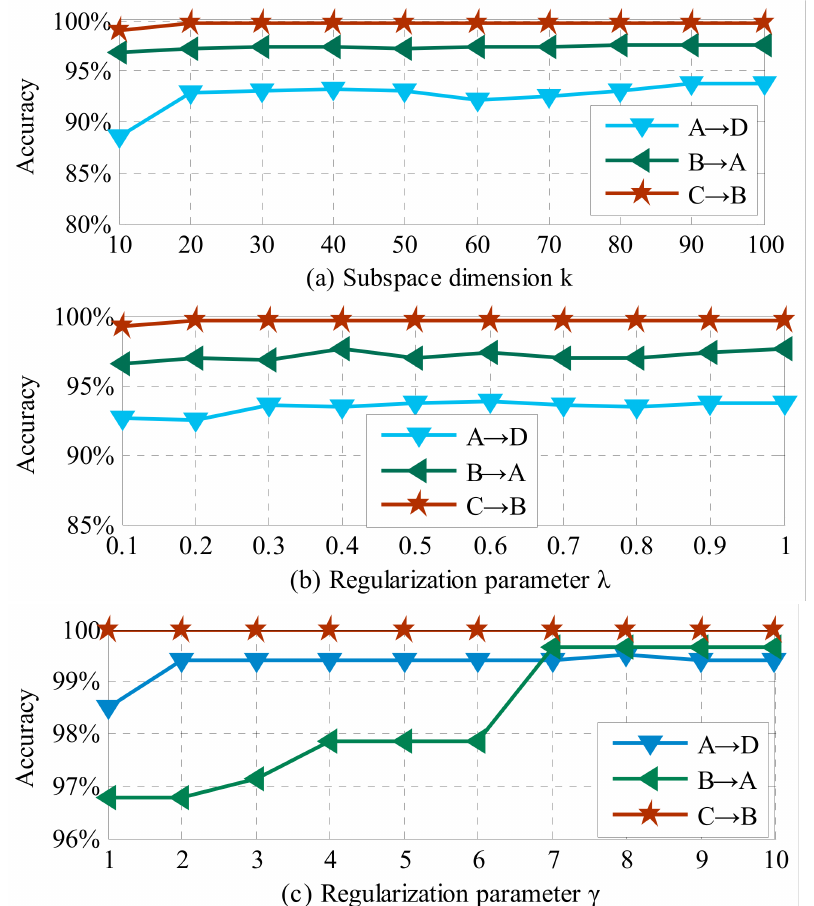
Figure 7. Parameter sensitivity for MRMI on rolling bearing